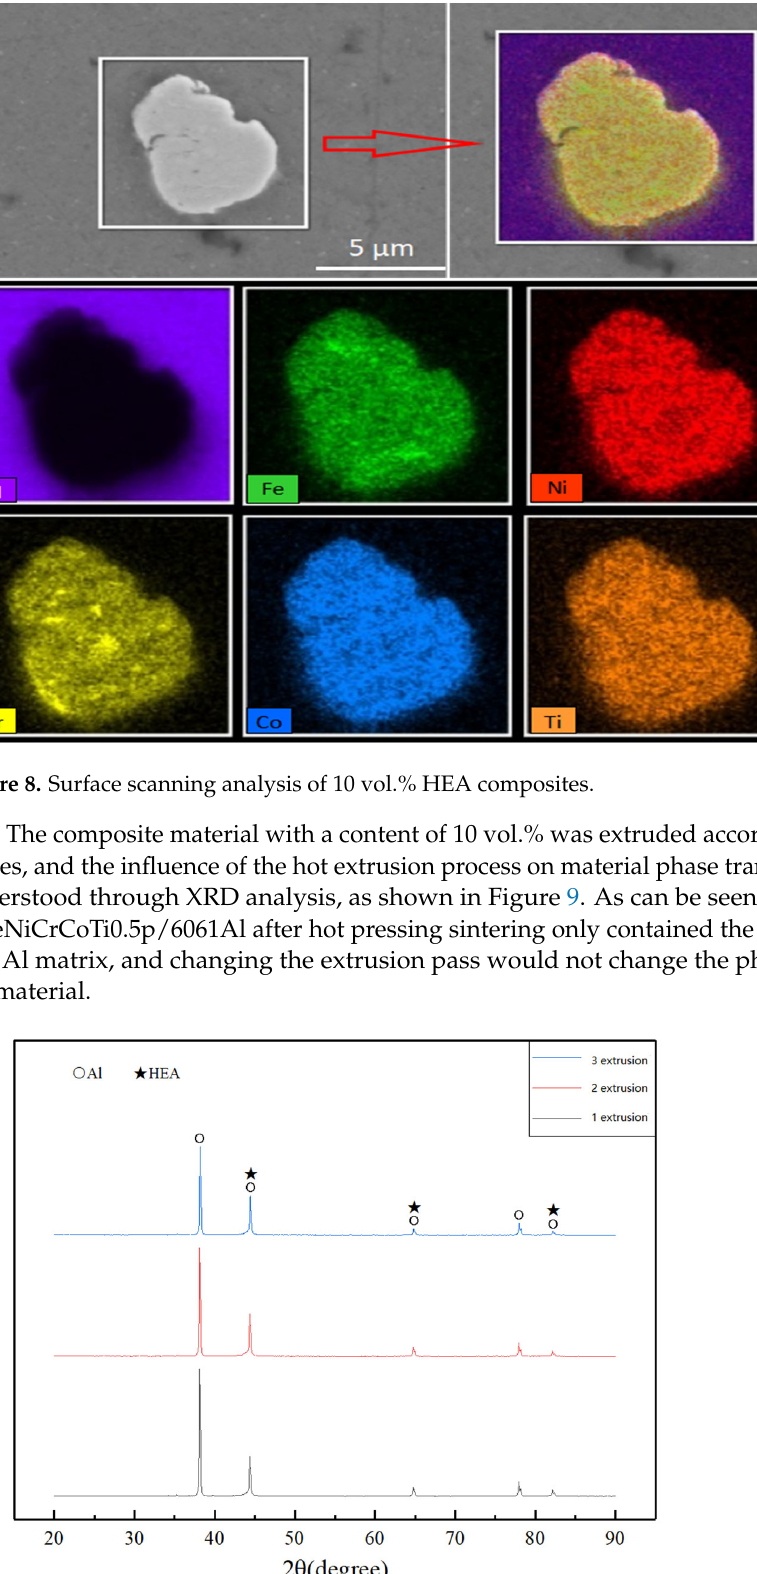
Figure 9. XRD patterns of 10 vol.% AlFeNiCrCoTi0.5 composites with different extrusion passes.